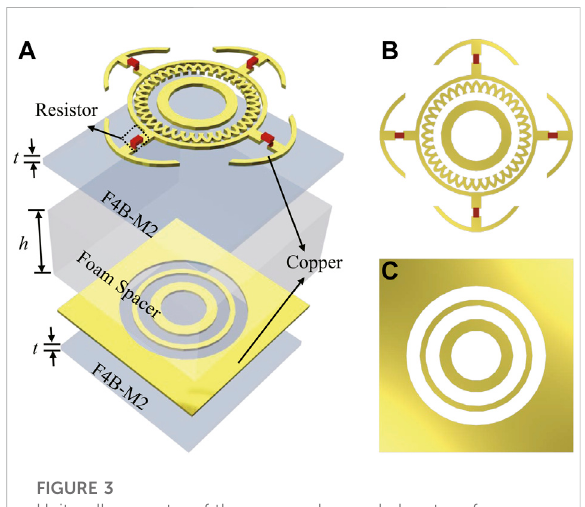
FIGURE 3 Unit-cell geometry of the proposed cascaded metasurface (A) Perspective view of the whole device. (B) Top view of the resistive layer. (C) Top view of the bandpass